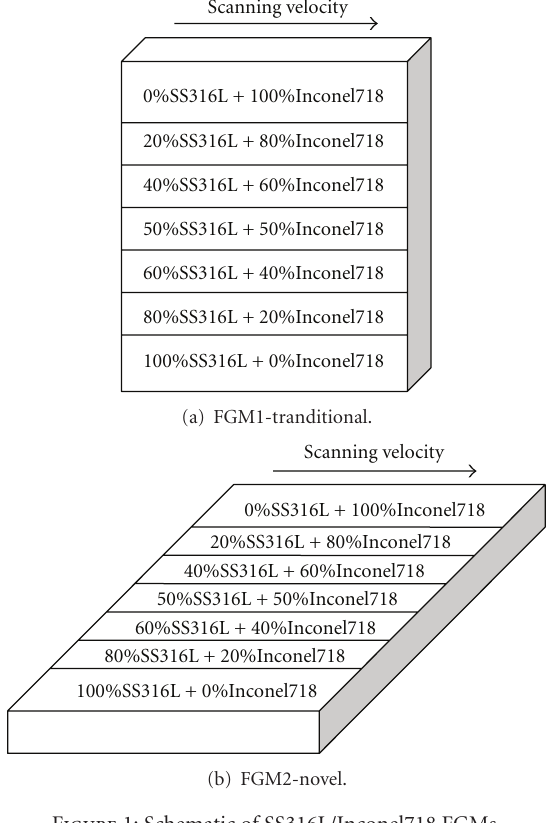
Figure 1: Schematic of SS316L/Inconel718 FGMs. Table 1: Chemical composition and size of the powders. Chemical composition and size of the powders Powders